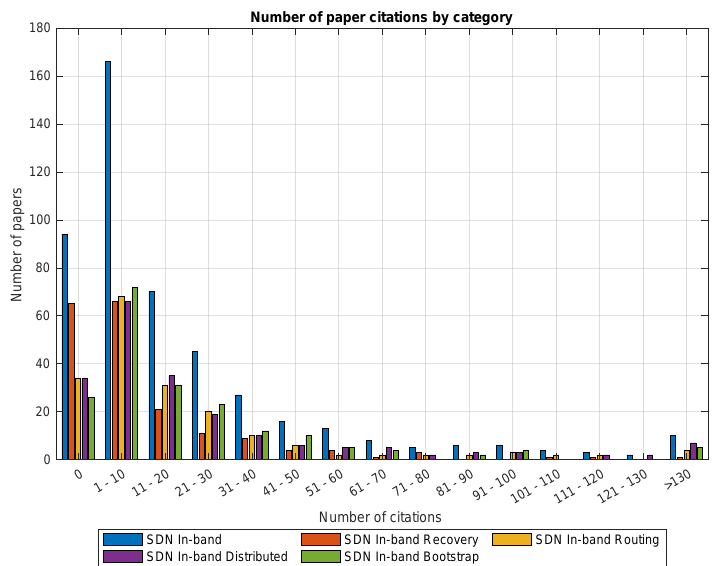
Figure 4. Number of papers related to SDN in-band and their amount of citations.